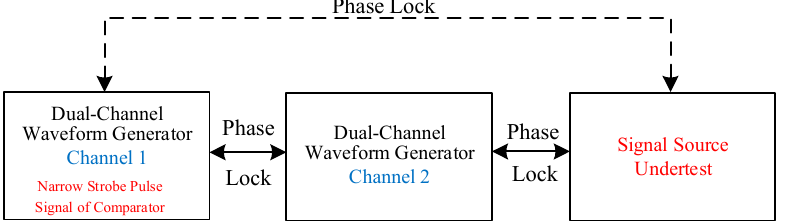
Figure 5. Phase locking correspondence.